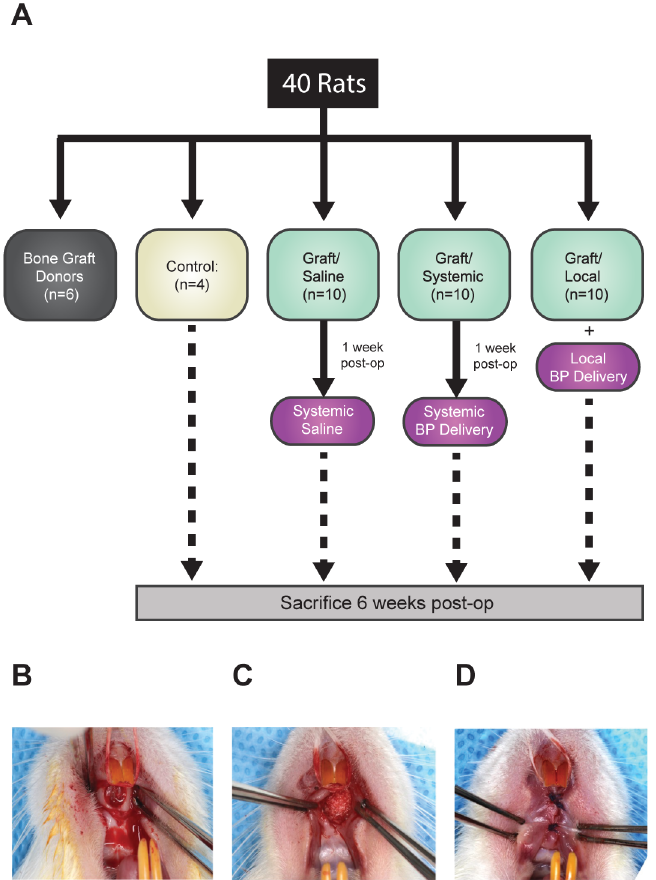
Fig 1. Experimental design and palatal defect/bone grafting animal model. (A) Thirty-four Fischer F344 Inbred rats were dividedinto four groups: (1) Control: The defect was created but no bone graft was placed; (2) Graft/Saline: Bone graft with systemic saline injection; (3) Graft/Systemic: Bone graft with systemic BP injection; (4) Graft/Local: Bone graft with local BP delivery.(B) A longitudinalmucosal incision made down the middleof the palate and a surgically created 3 mm defect using a slow-speedhandpiece and trephinebur. (C) Placement of bonegraft particles from isograft donors. (D) Palatal soft tissue closure with simple, interrupted